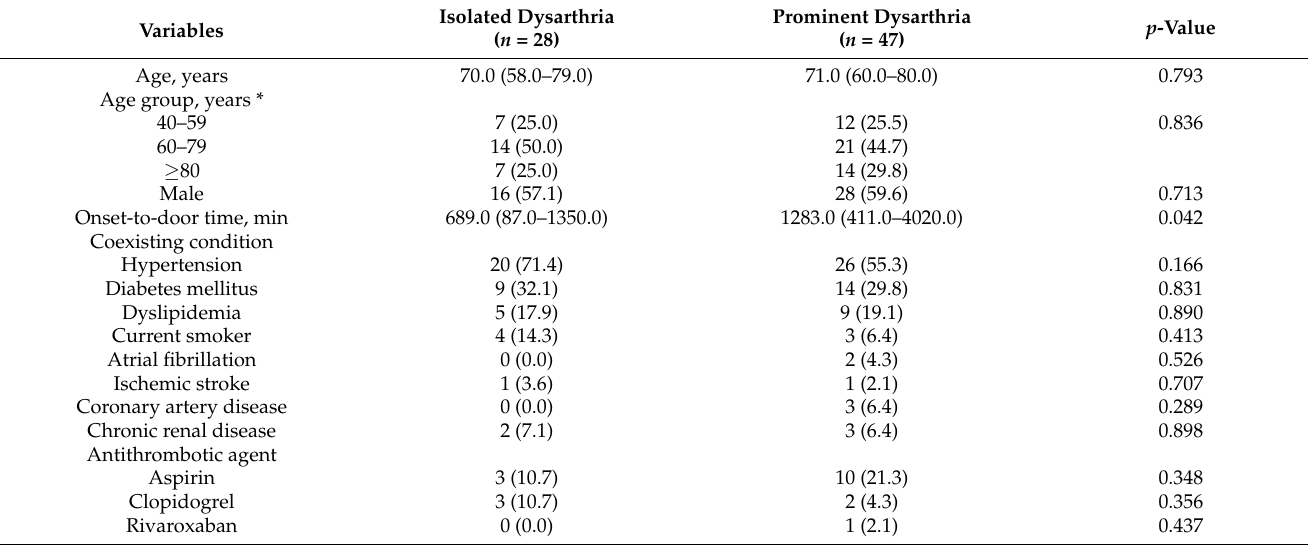
Table 1. Characteristics of patients with isolated or prominent dysarthria.